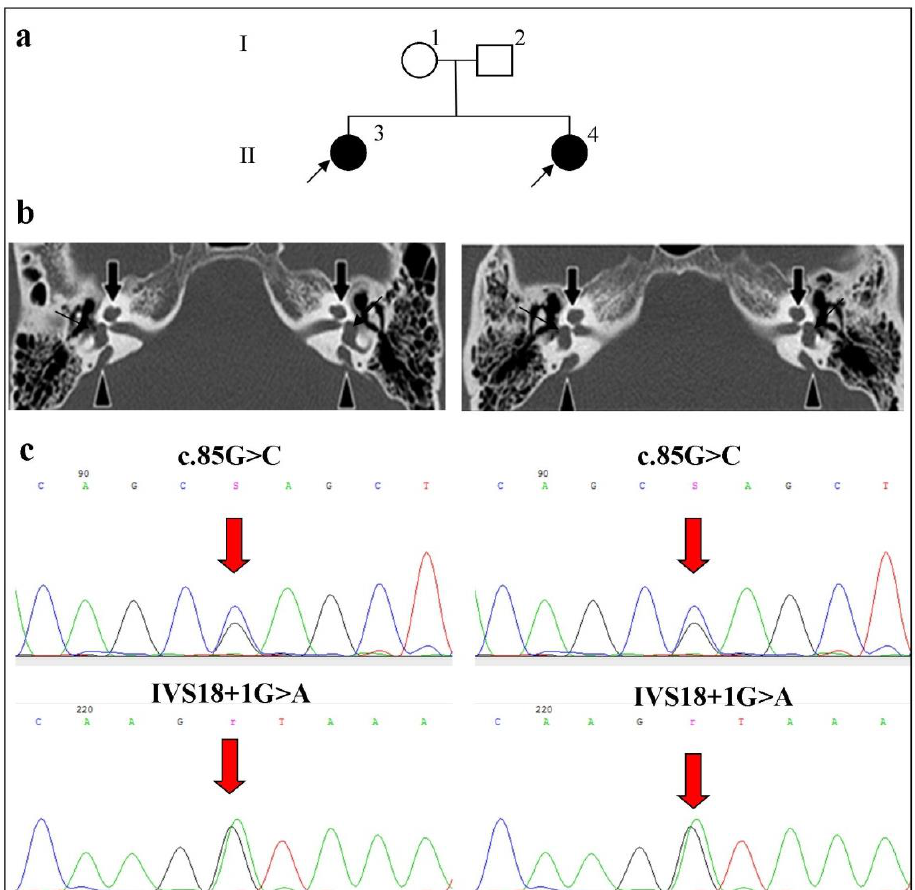
Figure 2. Identification of the c.85G>C p.(Glu29Gln) and c.2089+1G>A (IVS18+1G>A) variants in the SLC26A4 gene in the compound heterozygous state in siblings with bilateral IP-2 and EVA anom- alies. Note. ( a ) Pedigree of the patients (individuals with HL are highlighted in black; arrows in- dicate probands). ( b ) Computed tomography (CT) of the temporal bones in the axial projection of Patients II:3 and II:4 with IP-2 and EVA (black filled arrows indicate the cystic cochlea;